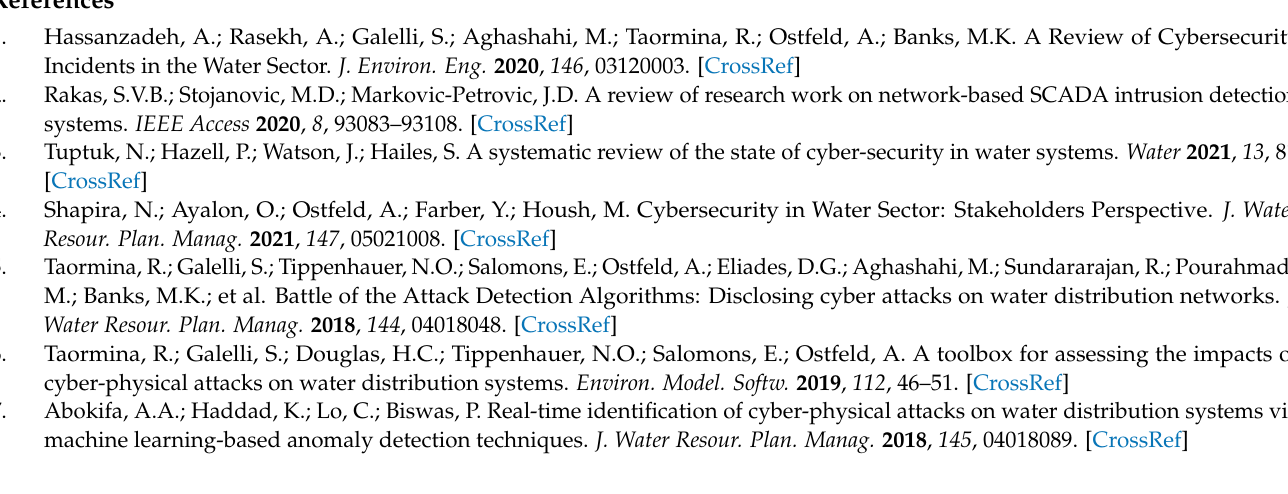
Figure A3. SSDS performance under different levels of data exposure.